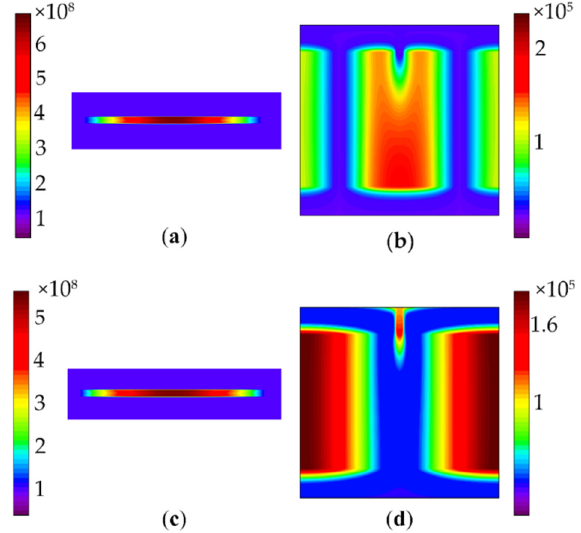
Figure 6. The calculated electric-field and magnetic-field distributions by using the Lumerical FDTD Solutions software. ( a ) The top view of electric-field distribution at 5.5 μ m; ( b ) the cross-section view of magnetic-field distribution at 5.5 μ m; ( c ) the top view of electric-field distribution at 7.8 μ m; (d) the cross-section view of magnetic-field distribution at 7.8 μ m.